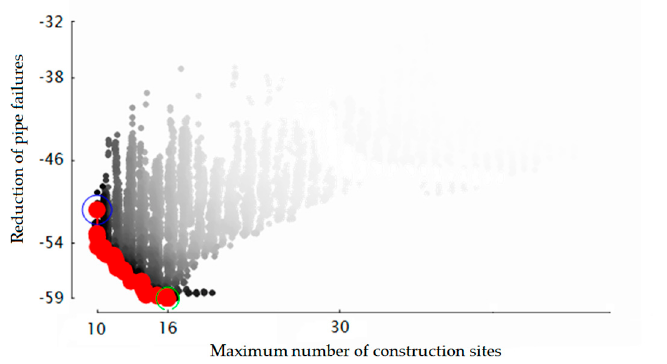
Figure 4. Obtained Pareto front: trade-off between the maximum number of construction sites and the reduction of pipe failures (red). The grey dots represent previous solutions obtained during the optimization process.